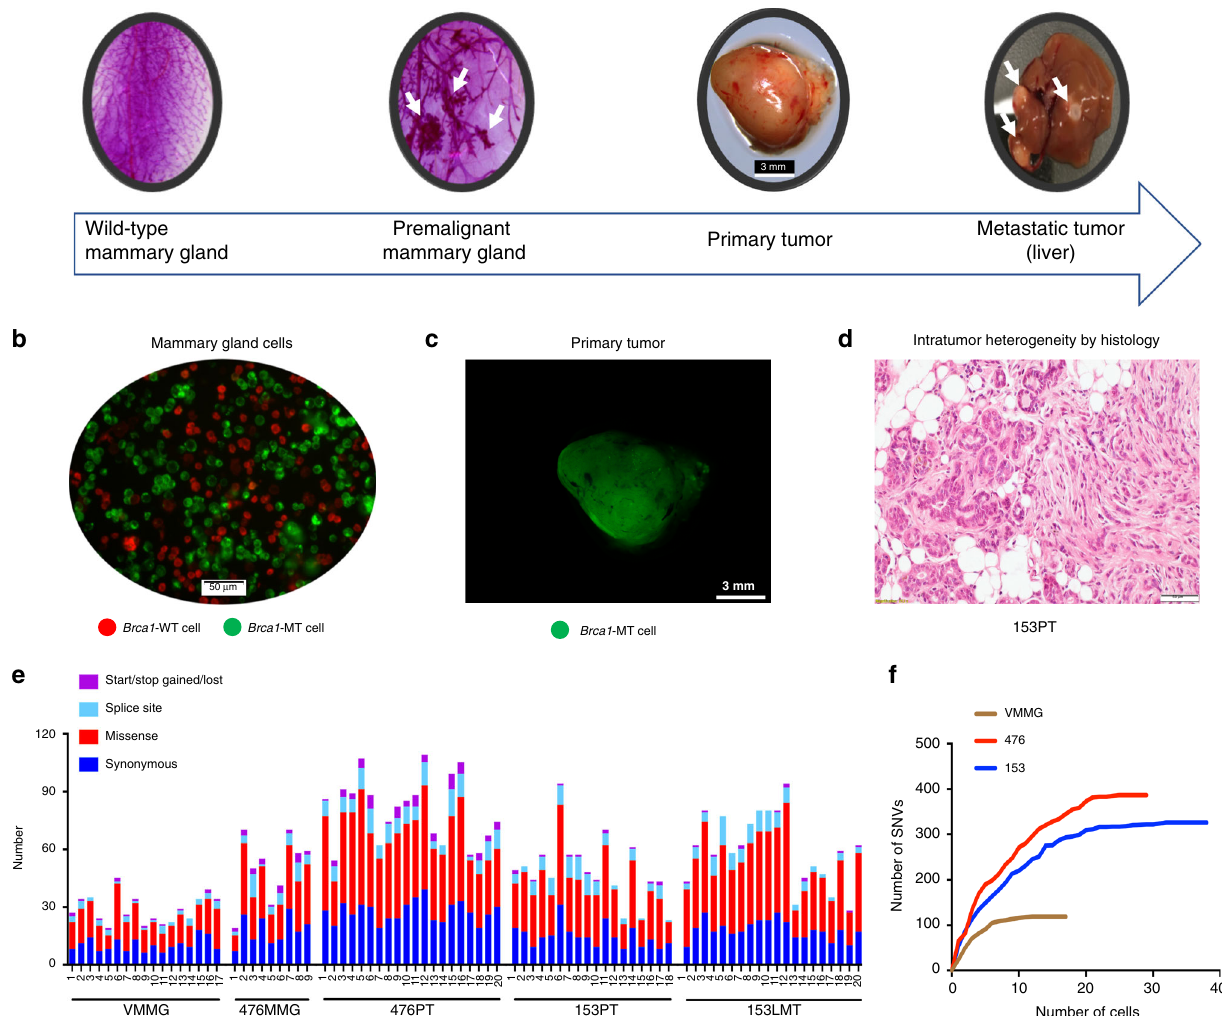
Fig. 3 Somatic SNV spectrum of mammary and tumor tissues with Brca1 de fi ciency revealed by scWES. a The single cells and paired bulk tissues from different tumor developmental stages of Brca1 + / + ;MMTV-Cre;mT/mG and Brca1 co/co ;MMTV-Cre;mT/mG mice were sequenced. Wild-type mammary gland refers to the Brca1 -wild-type mammary gland from 4-month-old mice with normal morphogenesis of mammary ductal tree. The premalignant mammary gland indicates the Brca1 -de fi cient mammary gland with abnormal morphogenesis of mammary ductal tree. The arrows of the second panel indicate premalignant mammary gland hyperplastic foci. The arrows of the fourth panel indicate metastatic tumors buried in the liver. Scale bar, 3 mm. b Representative Brca1 -WT and Brca1 -MT mammary gland cells from Brca1 -de fi cient mammary gland tissue. GFP (green) indicates Brca1 -MT cells, Tomato (red) indicates Brca1 -WT cells. Scale bar, 50 µ m. c Representative Brca1 -de fi cient primary breast tumor from Brca1 co/co ;MMTV-Cre;mT/mG mouse. GFP indicates Brca1 -MT cells. Scale bar, 3 mm. d Representative H&E staining of the primary tumor from mouse 153 showing intratumor heterogeneity. Scale bar, 50 μ m. e Quanti fi cation of exonic mutations according to the mutation type of Brca1 -MT cells from different tumor developmental stages. VMMG, virgin mutant mammary gland cells (i.e., early stage of premalignant mammary gland cells from 4-month-old mouse); 476MMG, 476 mutant mammary gland cells (i.e., late stage of premalignant mammary gland cells from 11-month-old tumor-bearing mouse #476); 476PT, 476 primary tumor cells (i.e., malignant primary tumor cells from 11-month-old tumor-bearing mouse #476); 153PT, primary tumor cells (i.e., malignant primary tumor cells from 11- month-old tumor-bearing mouse #153); 153LMT, liver metastatic tumor cells (i.e., malignant metastatic tumor cells from 11-month-old tumor-bearing mouse #153). f Saturation curve of SNVs of single cells in each